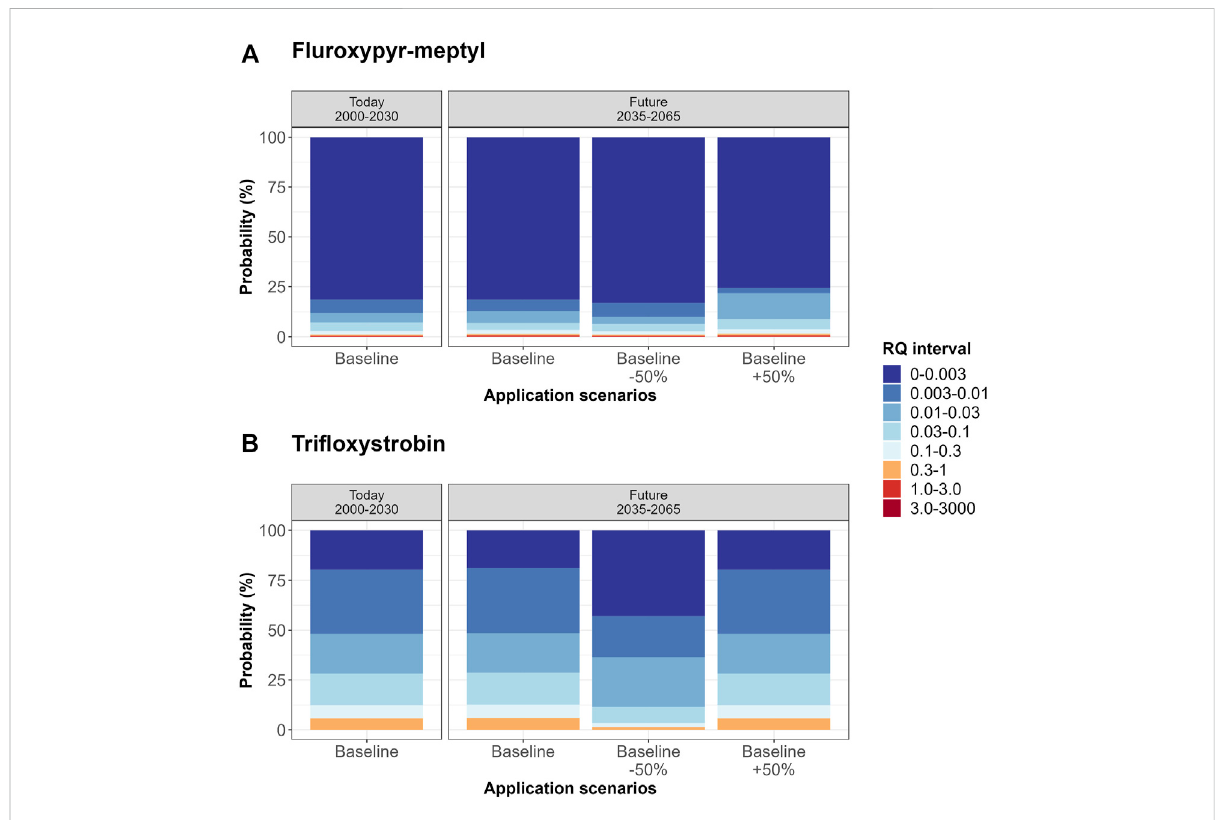
FIGURE 6 Predicted risk quotient distributionfor a selected herbicide and fungicide, for a time since application of1 day, for the climate model C1and for EC50-based effects distribution. The scenarios 1,4,5,6 (Table 3) are displayed for the herbicide fl uroxypyr-meptyl (A) and the fungicide tri fl oxystrobin (B)